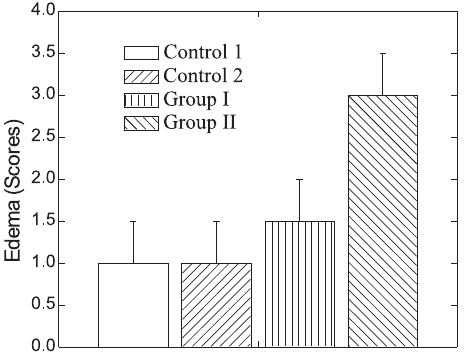
Figure 3. Comparison of histological edema (scores) between controls, Group I, and Group II rats (p <